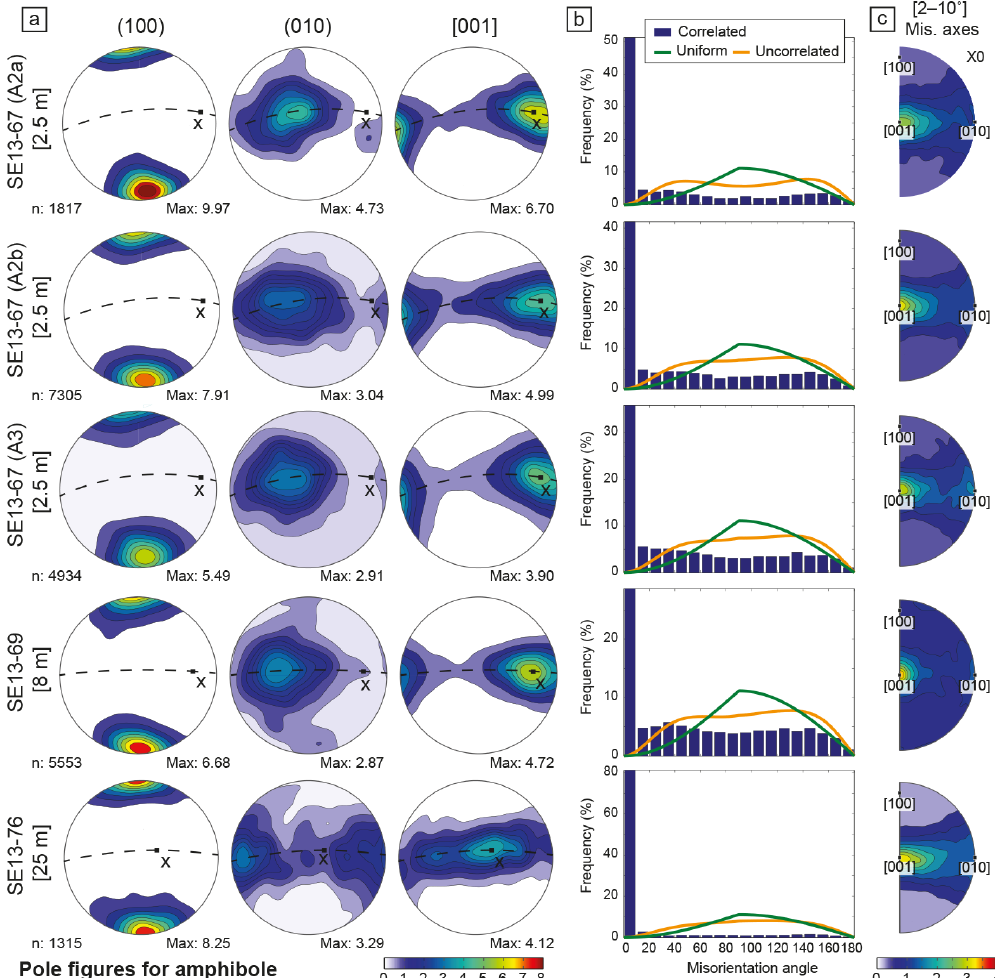
Figure 8. (a) Pole figures illustrating amphibole CPO of the samples from the HTa unit in Sumeini massif. Samples are sorted using the distance from the peridotite, with increasing distance downwards. The dashed line represents the foliation and X points to the lineation. Contours are multiples of a uniform distribution. All plots are lower hemisphere projections. Numbers in square brackets refer to the distance to the peridotite. n : number of grains; (b) distribution of misorientation angles between correlated (adjacent) pixels (blue histogram) and between uncorrelated pixels (orange curve) of amphibole. The uniform (green) curve corresponds to the theoretical misorientation distribu- tion for perfectly randomly oriented crystals; (c) amphibole inverse pole figures showing the distribution of correlated misorientation axes (between 2 and 10 ◦ ). Contours are multiples of uniform